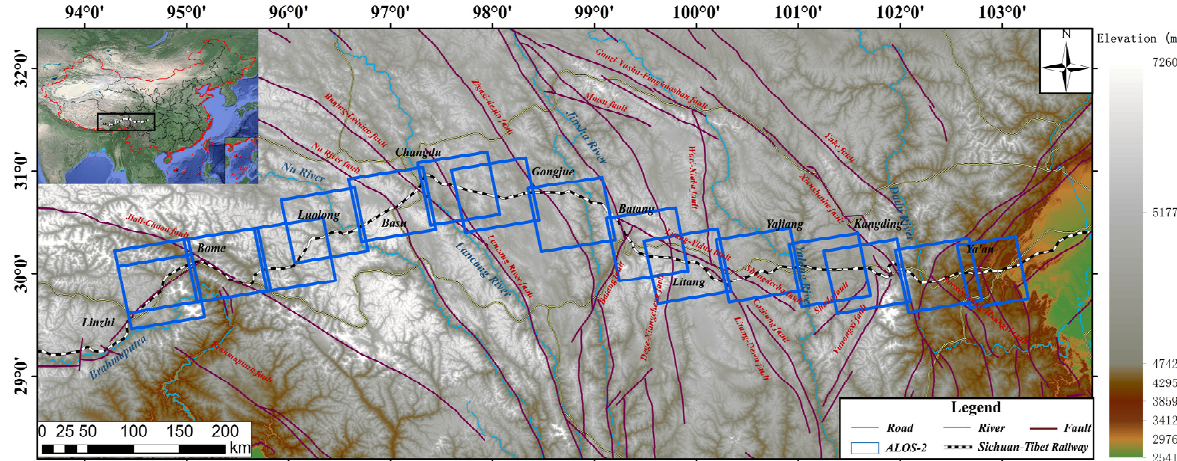
Figure 1. Study area and synthetic aperture radar (SAR) image coverage. The background is the shaded relief obtained by the shuttle radar topography mission digital elevation model (SRTM DEM). Upper left corner black rectangle indicates the location of the study area in China.